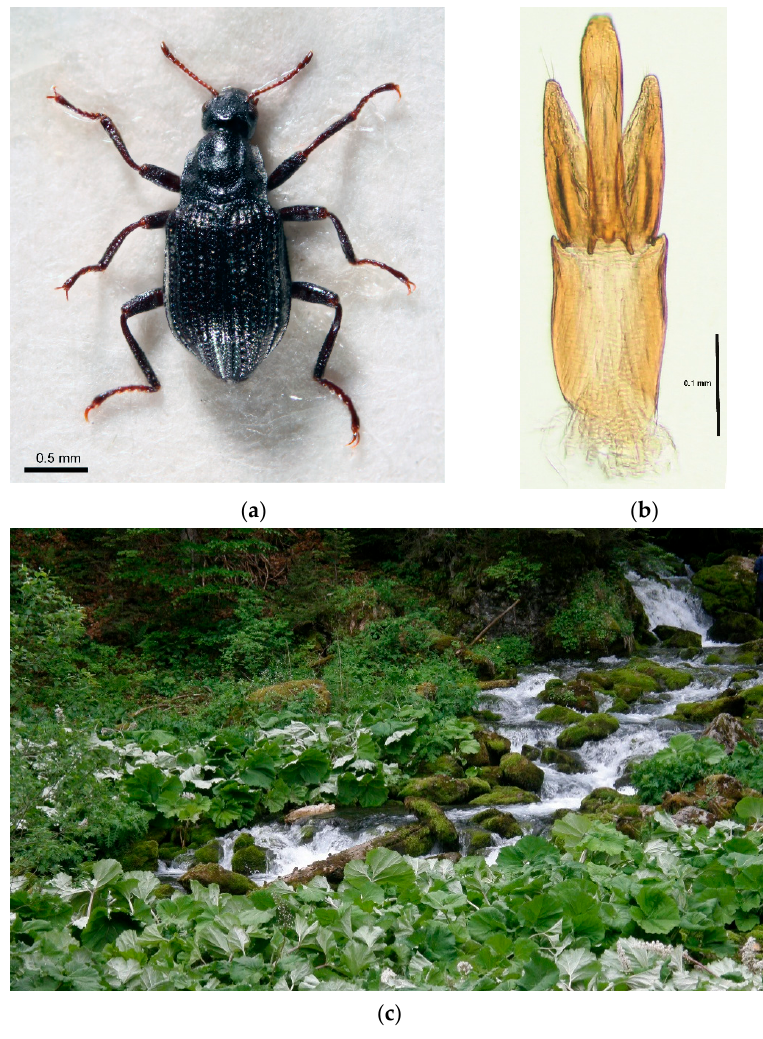
Figure 1. Elmis bosnica Zaitzev, 1908: ( a ) habitus; ( b ) aedeagus—ventral side; ( c ) typical habitat: Figure 1. E. bosnica (Zaitzev, 1908): ( a ) habitus; ( b ) aedeagus—ventral side; ( c ) typical habitat: Spring Spring of the Ibra River, Montenegro. of the Ibra River,